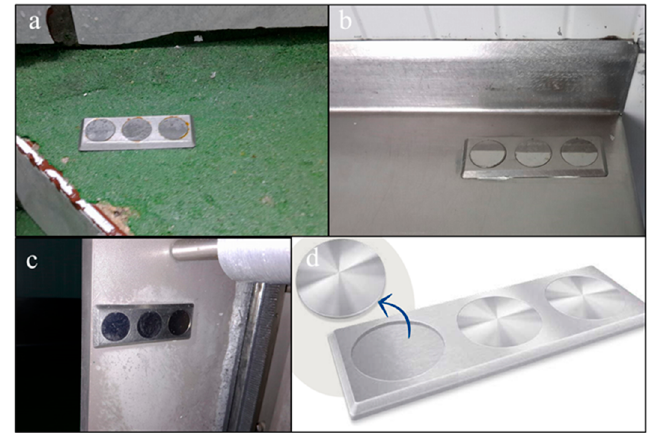
Figure 1. Examples of their placement in the collaborating industry: ( a ) Fresh meat carts cleaning room floor; ( b ) slicer B; and ( c ) vacuum machine slide. ( d ) Design of a SCH surface sensor [19].